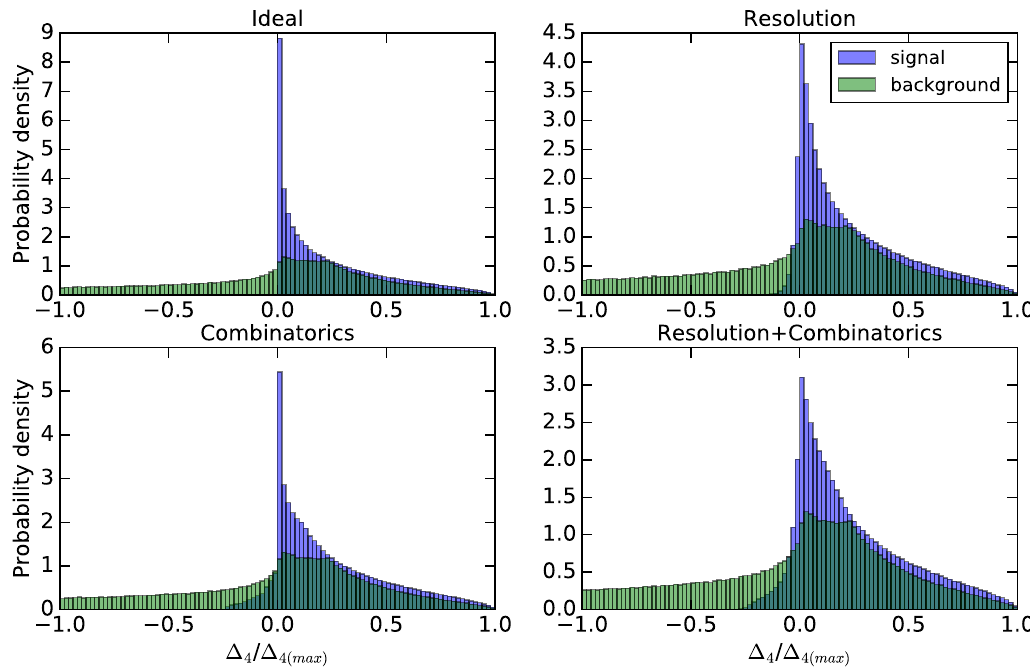
Figure 10 . The (cid:1) 4 histograms for signal (blue) and the SM background (green), with energy resolution and combinatoric ambiguities